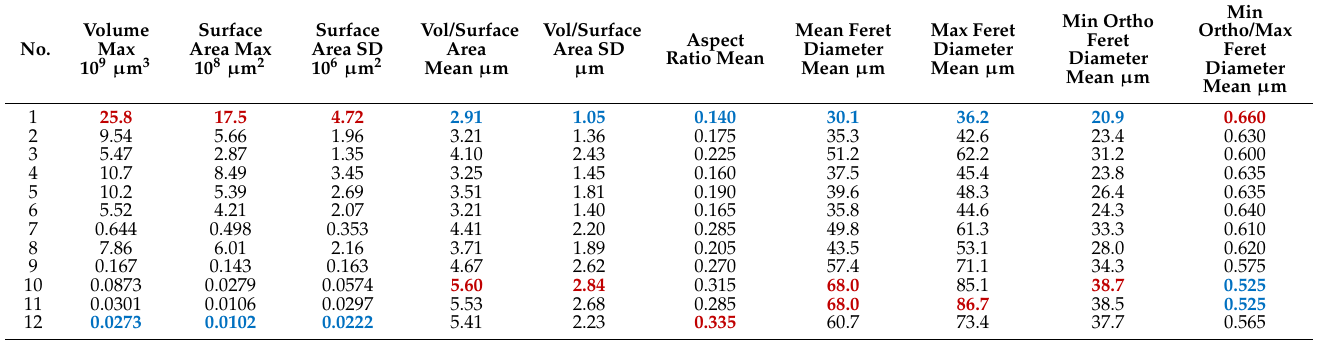
Table 4. Significant ( p < 0.05) variables related to size and shape parameters of pore